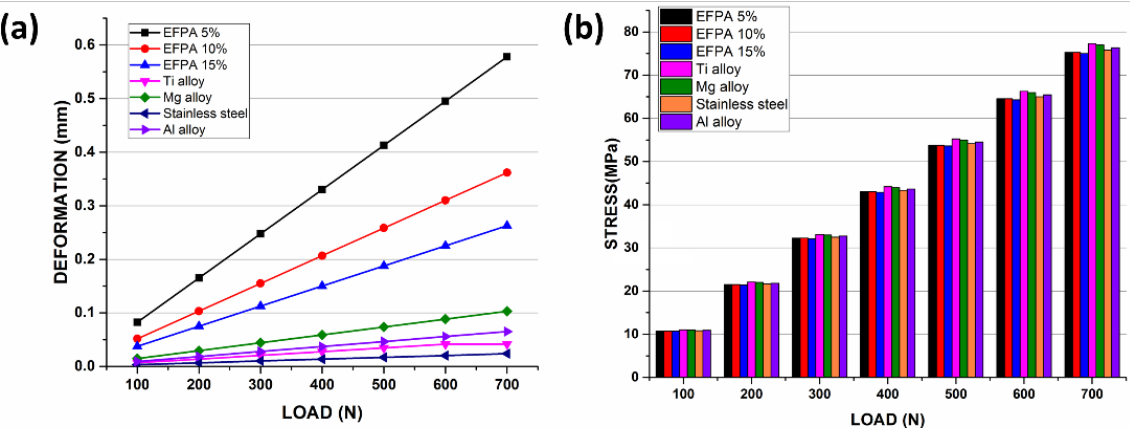
Figure 9. Graphs of Mode-3 showing ( a ) maximum stress vs. load and ( b ) maximum deformation vs. load.